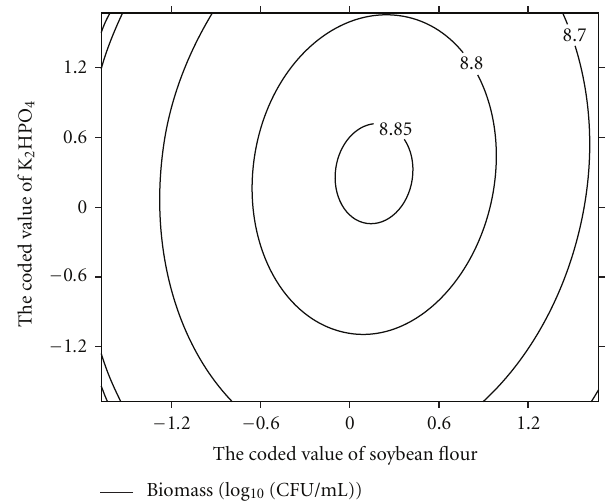
Figure 5: Contour plot for DNS 32 strain production as a function of X 2 (soybean concentration) and when the coded value of X 1 (corn flour concentration) was fixed at